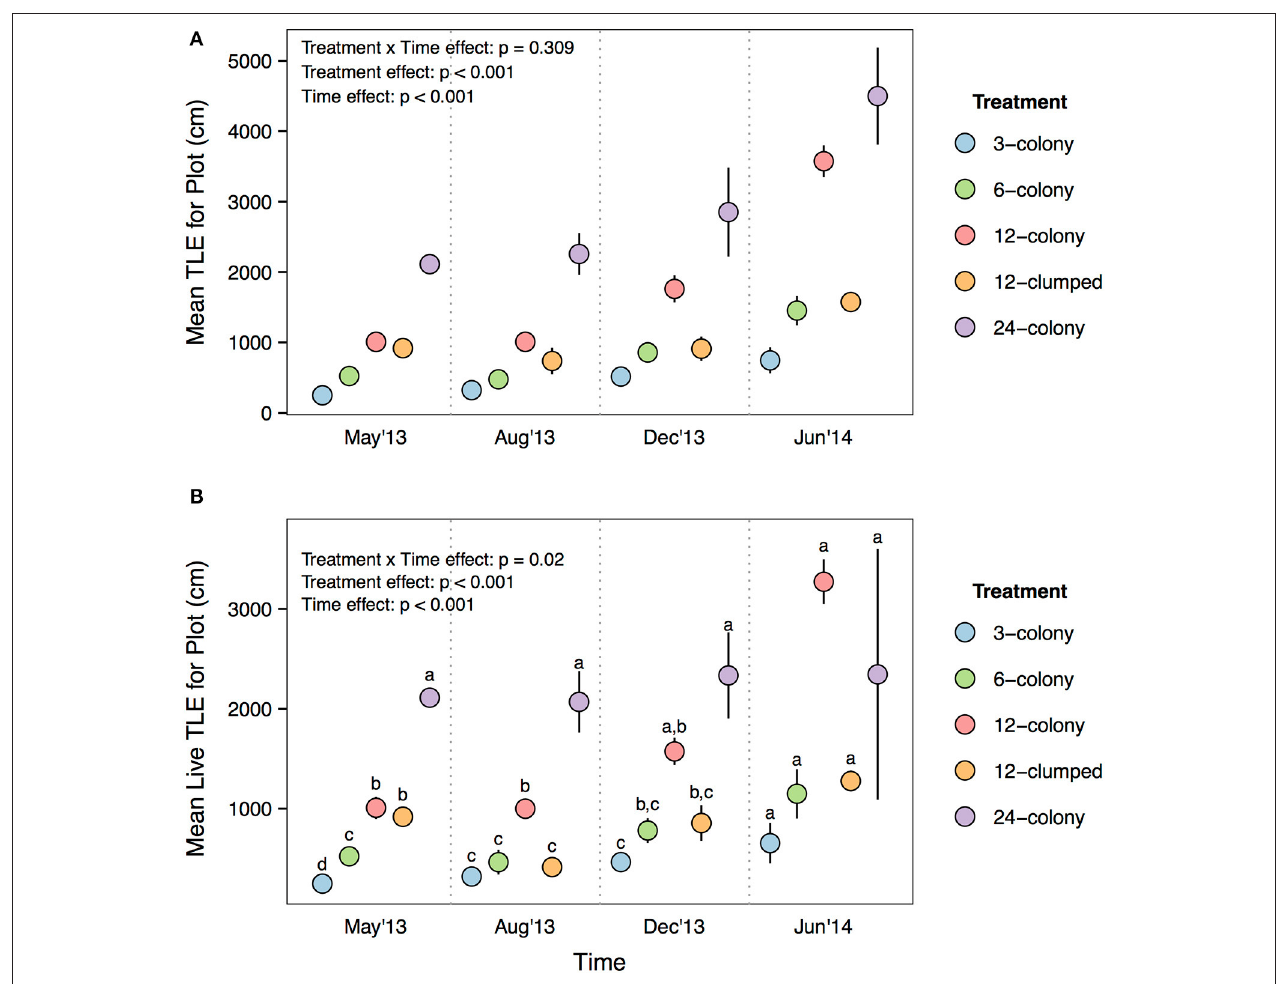
FIGURE 6 | (A) Total linear extension and (B) live TLE at the plot level comparing among treatments across each survey period. Statistics are from nested two-way repeated measures ANOVA. Letters represent significant differences ( p < 0.05) among treatments within a time period from post-hoc tests with Tukey’s correction. Data are means ±